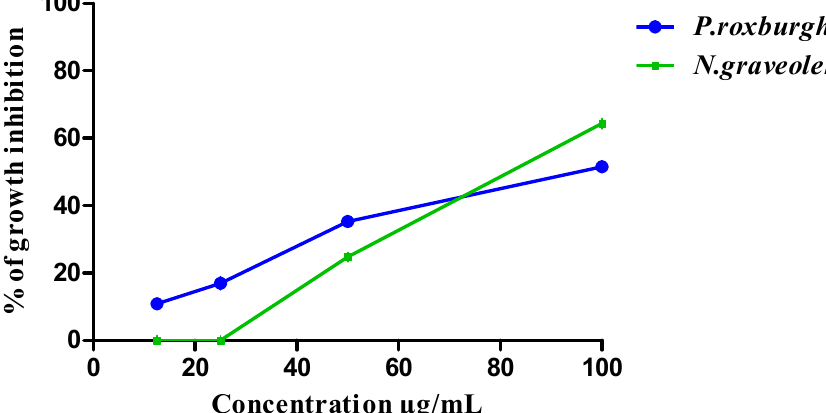
Figure 2. Impact of P . roxburghii and N . graveolens extracts at different concentrations on a normal human cell line (BJ ‐